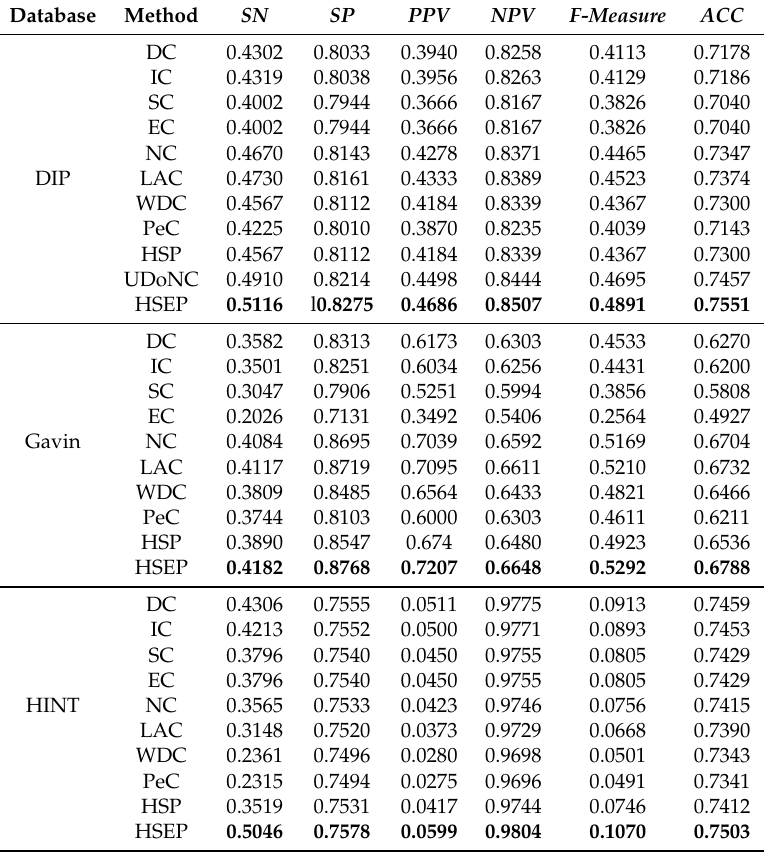
Table 2. Comparative analysis of HSEP and the other methods in terms of SN , SP , PPV , NPV , F − measure , and ACC on the PPI